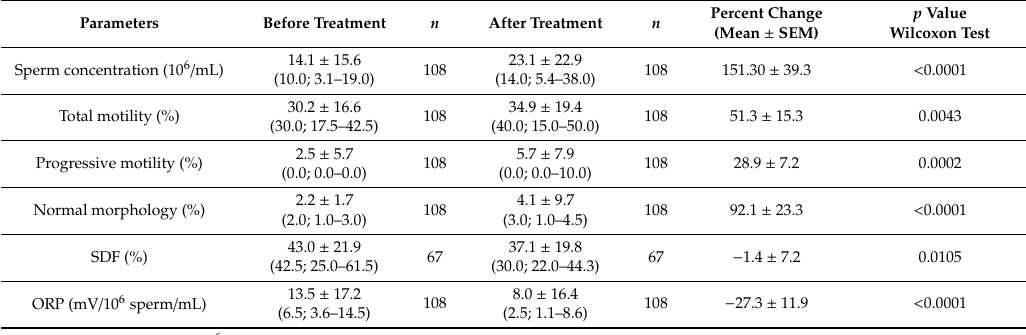
Table 3. Summary statistics of semen parameters, SDF, and ORP before and after the treatment with FH PRO for Men in idiopathic infertile patients having high ORP